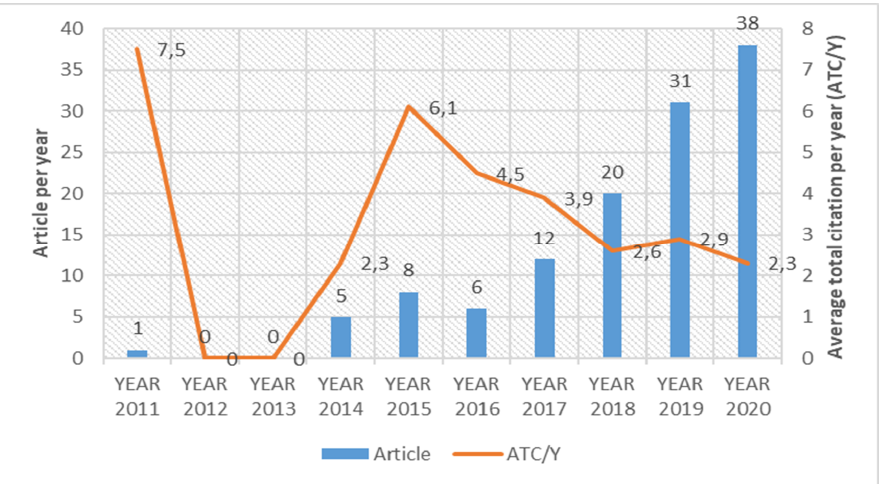
Figure 2. From 2011 through 2020, annual scientific productivity for PASSFDR publications indexed in Scopus. ATC/Y stands for average total citations of published papers per year. NB The annual percentage rate of increase is 68.14.